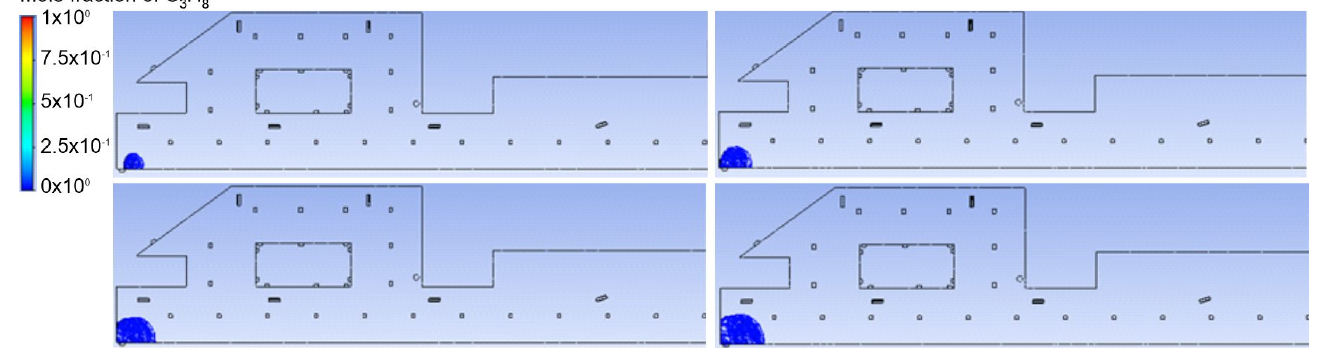
Figure 5. Lower explosive limit of LPG distribution in an underground garage after gas dispersion for A source for different time steps: 2.5 s, 5 s, 7.5 s and 10 s.